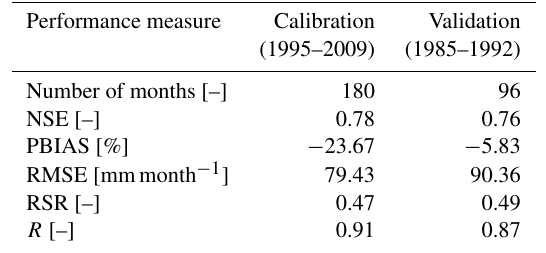
Table 1. Model performance measures for the water balance model AWARE forced by CFSv2 re-analysis data. NSE = Nash– Sutcliffe model efficiency, PBIAS = Percent Bias, RMSE = Root Mean Square Error, RSR = RMSE observations standard deviation ratio, R = Pearson’s correlation